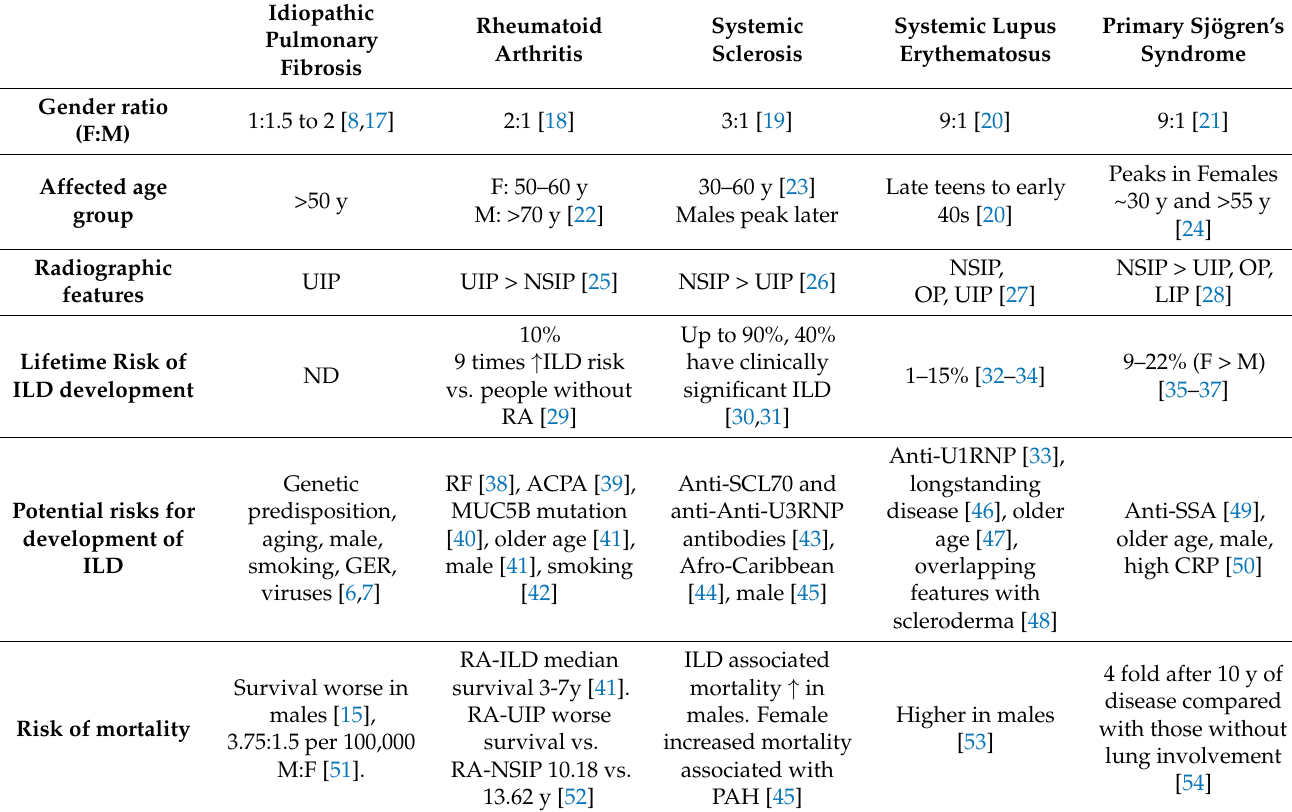
Table 1. Epidemiological and clinical sex differences in IPF and selected